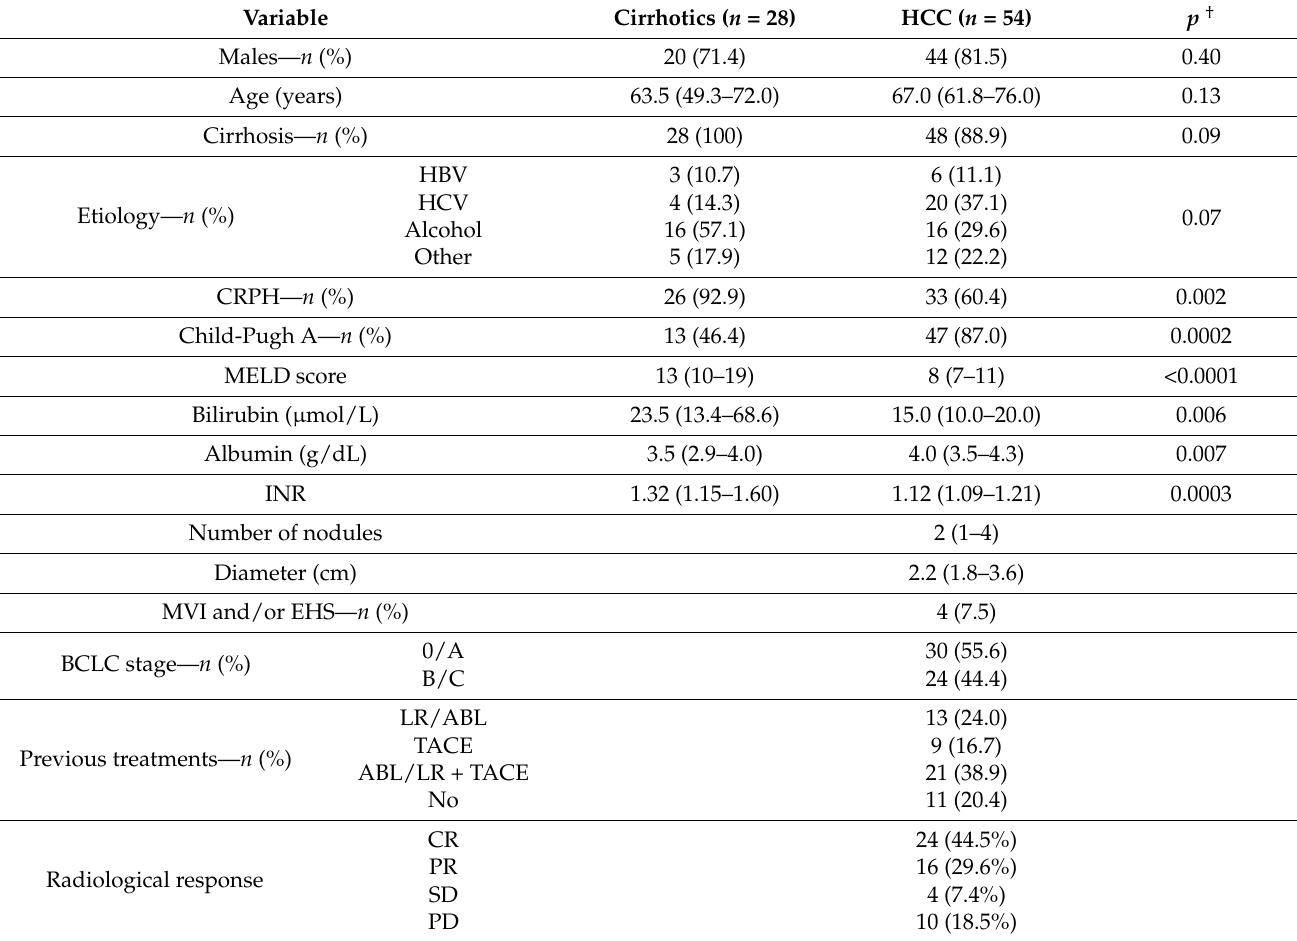
Table 1. Baseline characteristics of cirrhotic and HCC